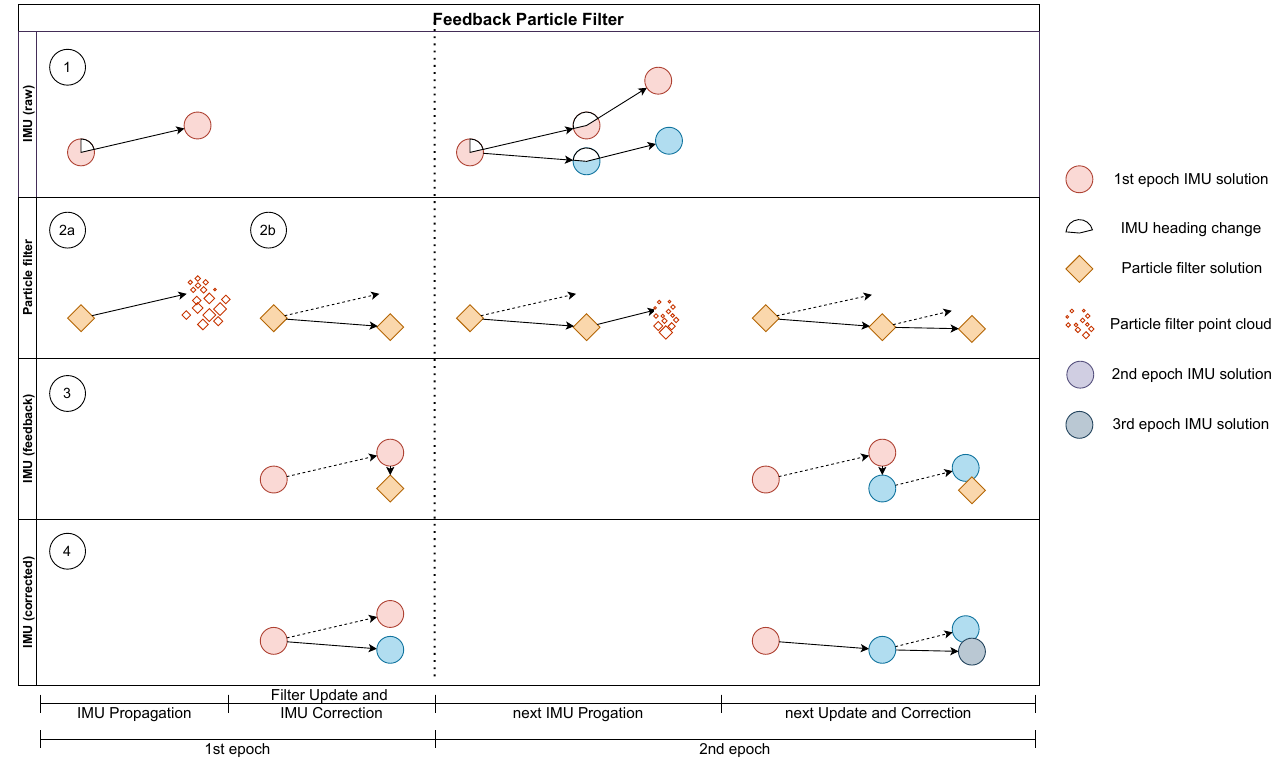
Figure 9. Schematic of the feedback